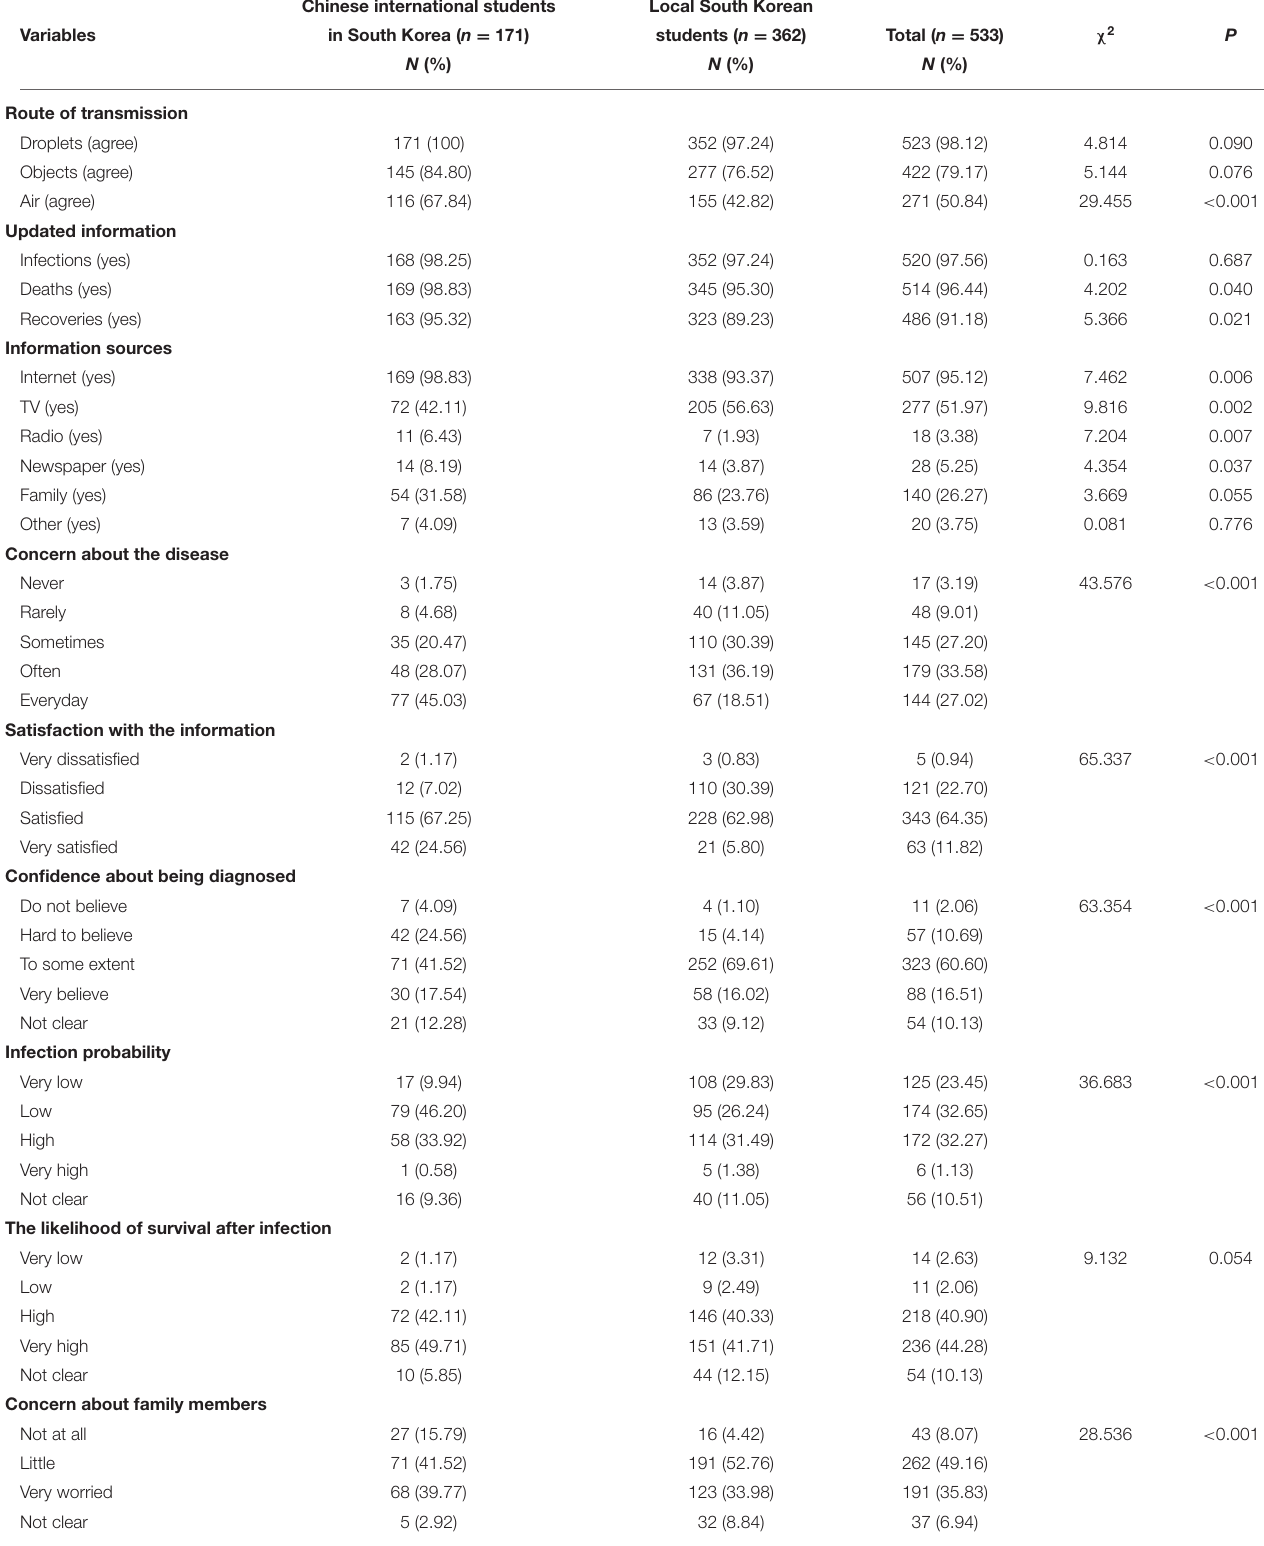
TABLE 2 | Differences in knowledge of